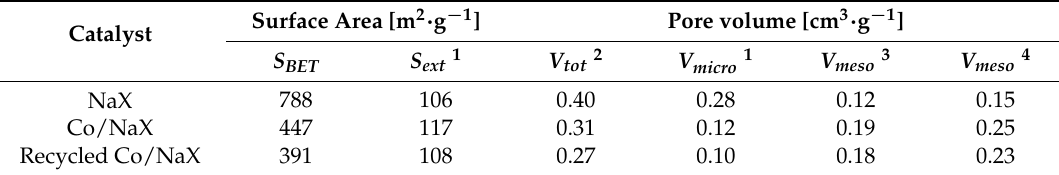
Figure 1. Nitrogen isotherms collected at 77 K of the (□) parent NaX zeolite, ( ○ ) Co/NaX, ( △ ) and recycled Co/NaX. Table 1. Physical properties of the parent zeolite and the fresh and recycled Co/NaX catalyst.